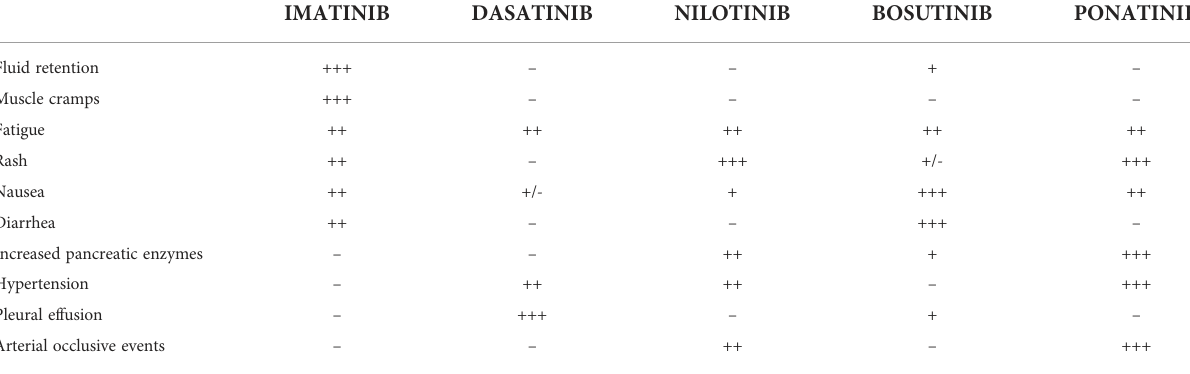
TABLE 1 Adverse events during TKI